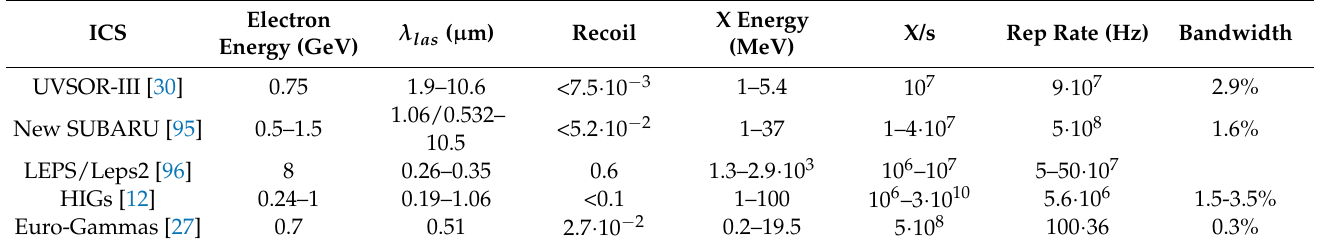
Table 4. High energy ICS; all data are measured, apart the EuroGammas ones that are